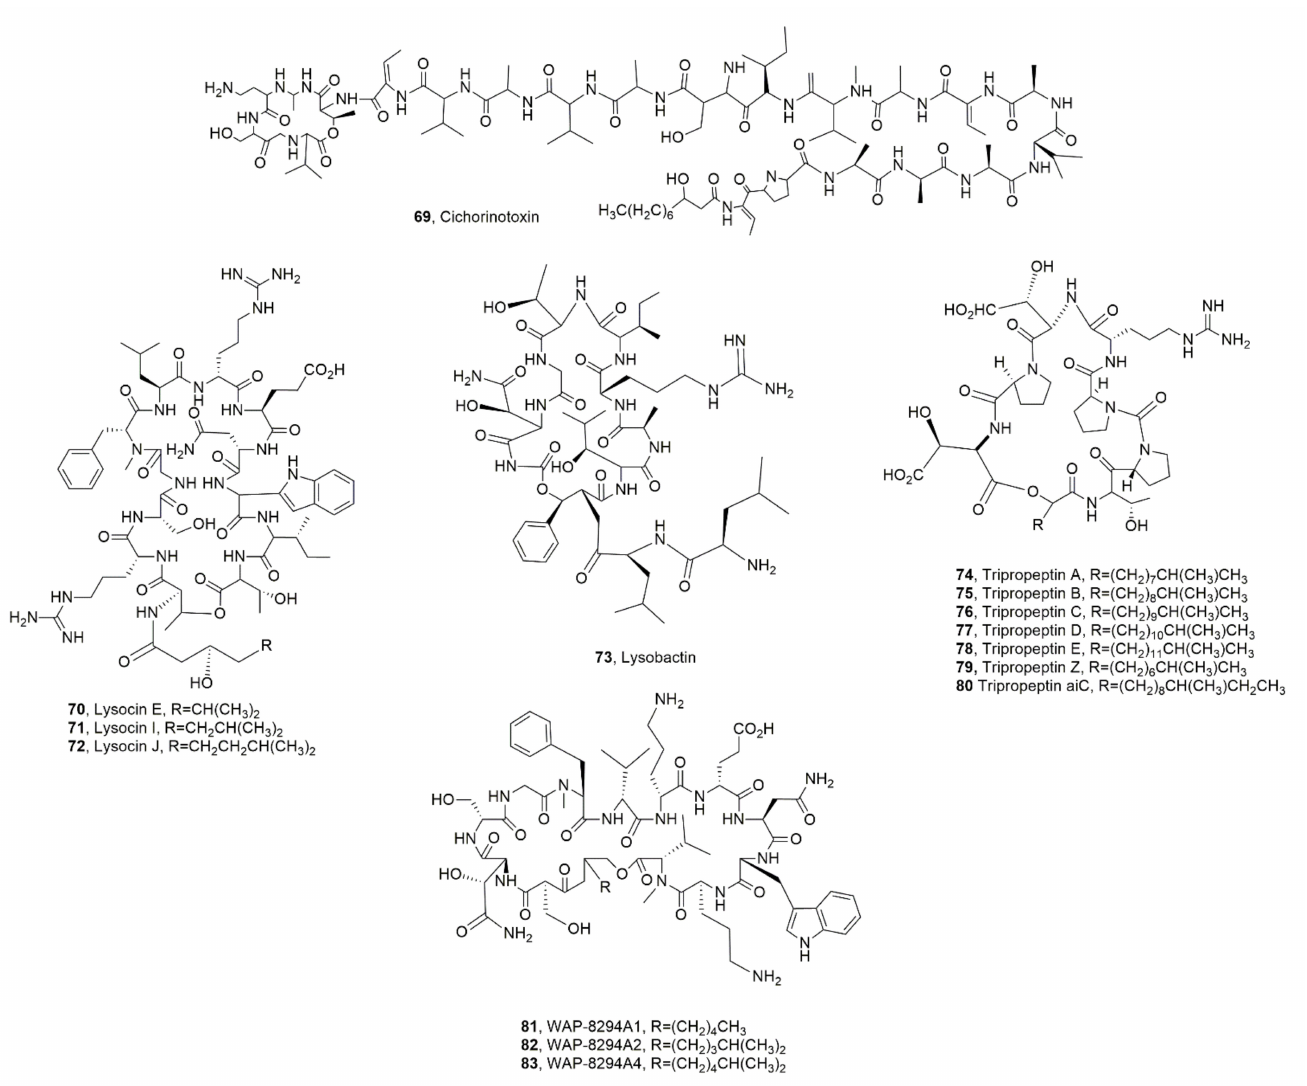
Figure 9. Lipodepsipeptides produced by Pseudomonas cichorii ( 69 ), and Lysobacter sp. ( 70 – 83 ). Lysocin E ( 70 , Figure 9) was isolated from Lysobacter sp. 3655, and belong to